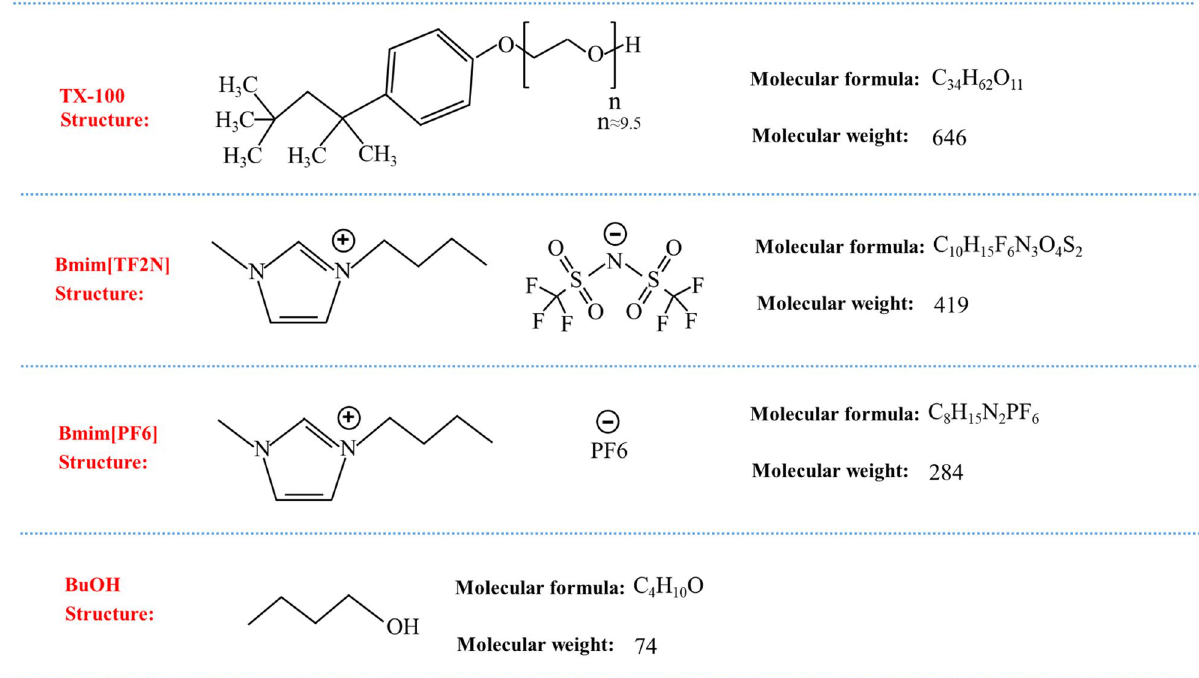
Figure 1. The molecular structure, formula and weight of TX-100, Bmim[TF2N], Bmim[PF6] and BuOH.